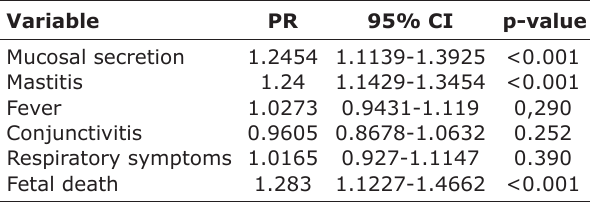
Table-6: Analysis of clinical manifestations as possible risk factors associated with BLV infection.